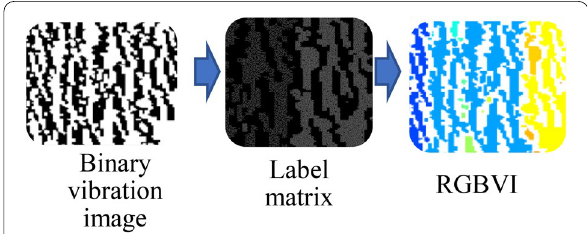
Figure 4 An example of connected components based RGB vibration image